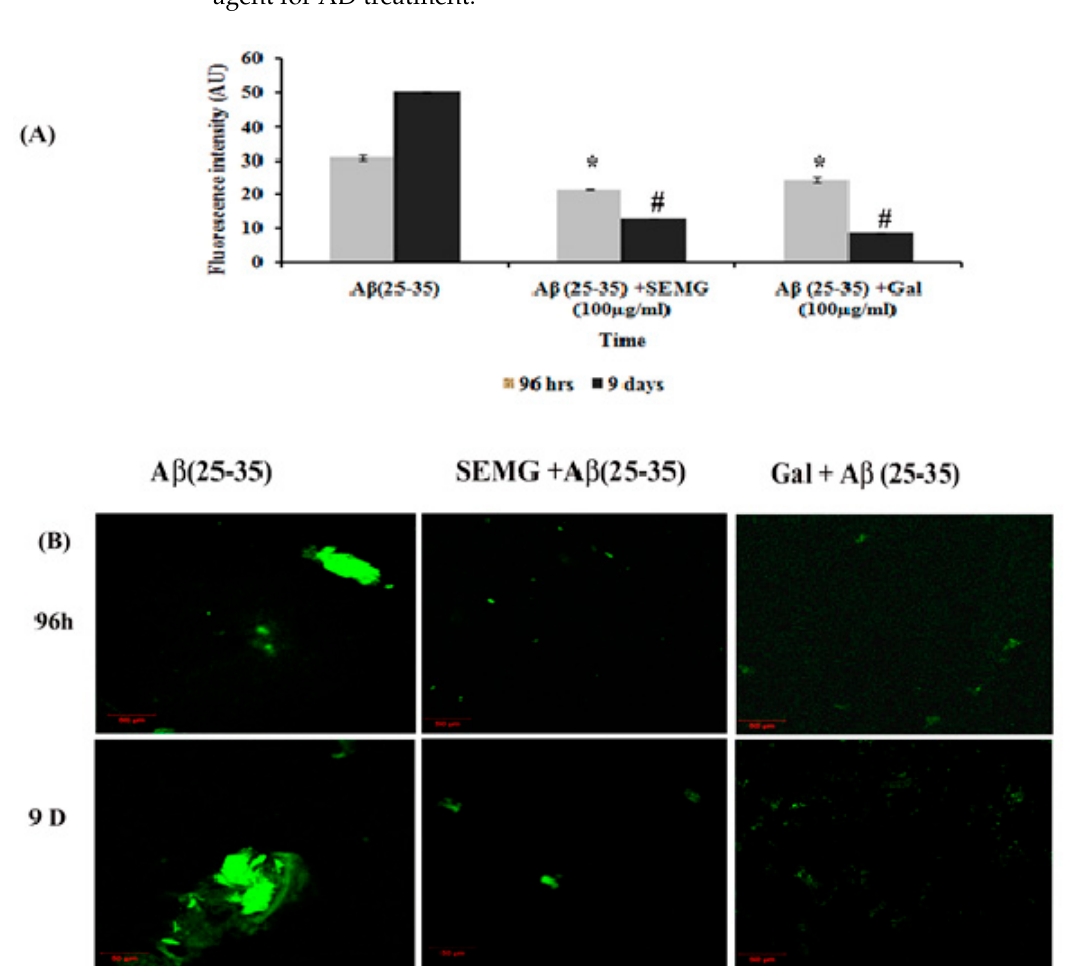
Figure 5. Effect of SEMG on the disintegration of preformed mature fibrils. ( A ) Th-T fluorescence assay, ( B ) confocal laser scanning microscopic analysis. *,# p < 0.05 represents statistically significant difference in comparison with treated groups with control and positive control group.